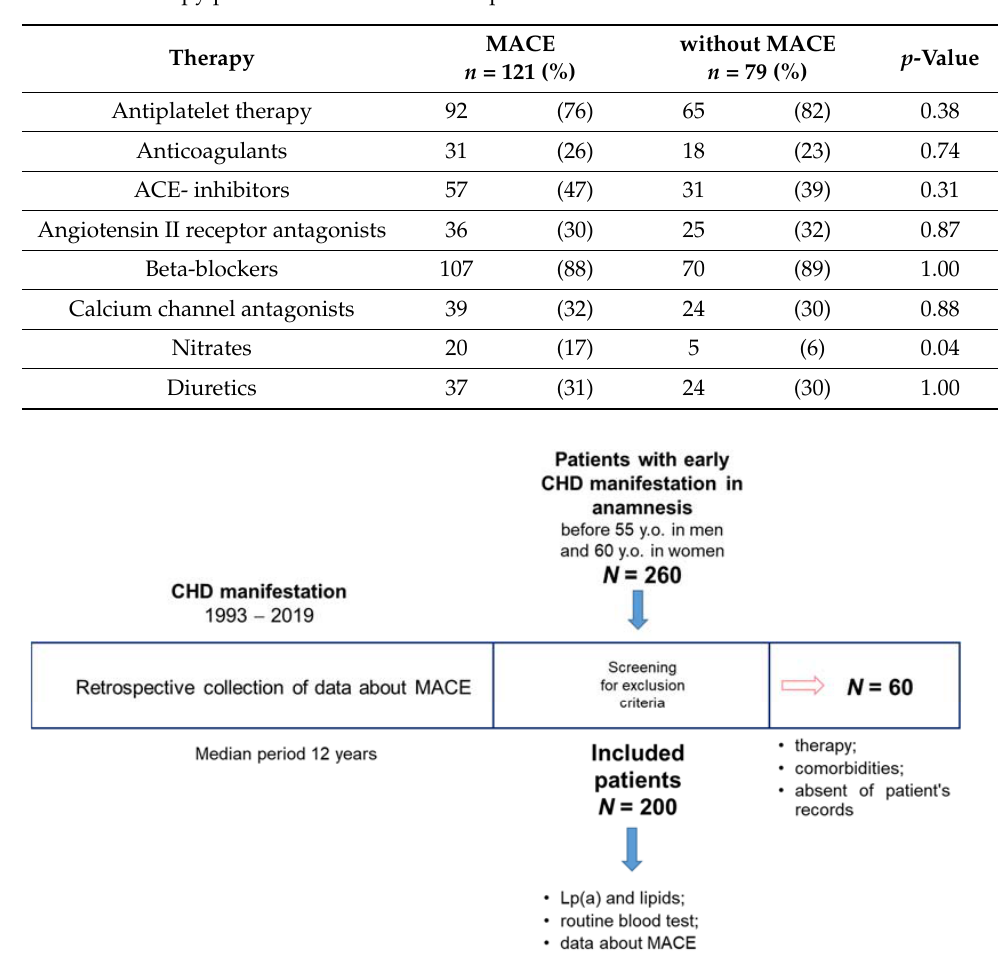
Figure A1. Design of the study. 260 patients with an early history of CHD hospitalized and screened between 2019 and 2021 were included during the screening phase. 60 people were expelled according to the exclusion criteria. The information about the presence or absence of any significant cardiovascular events as well as the date of each such event from the CHD manifestation was available for all patients according to medical records. All patients, after signing an informed consent, were re-examined, relevant medical data were collected, biochemical tests and routine blood tests were